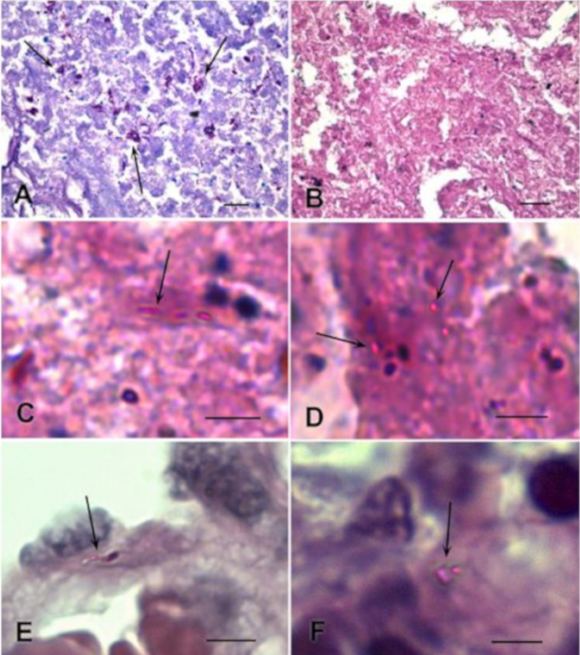
Figure 2. Ziehl–Neelsen staining of M. tuberculosis , in the lung tissue of TB patients, with di ff erent bacteria content. ( A ) Aggregations of M. tuberculosis in a region of caseous necrosis, in a sample of lung tissue with high bacterial content. ( B – F ) Examples of lung tissue with low bacterial content, selected for immunolabelling. ( B ) At low magnification, aggregations of M. tuberculosis are not visible. ( C , D ) High magnification of single small colonies of rod-shaped and rounded bacteria (arrows) in a region of caseous necrosis. ( E , F ) High magnification of single rod-shaped and rounded bacteria in the perifocal region. Scale bars: ( A , B ) = 10 µ m; ( C – F) = 5 µ